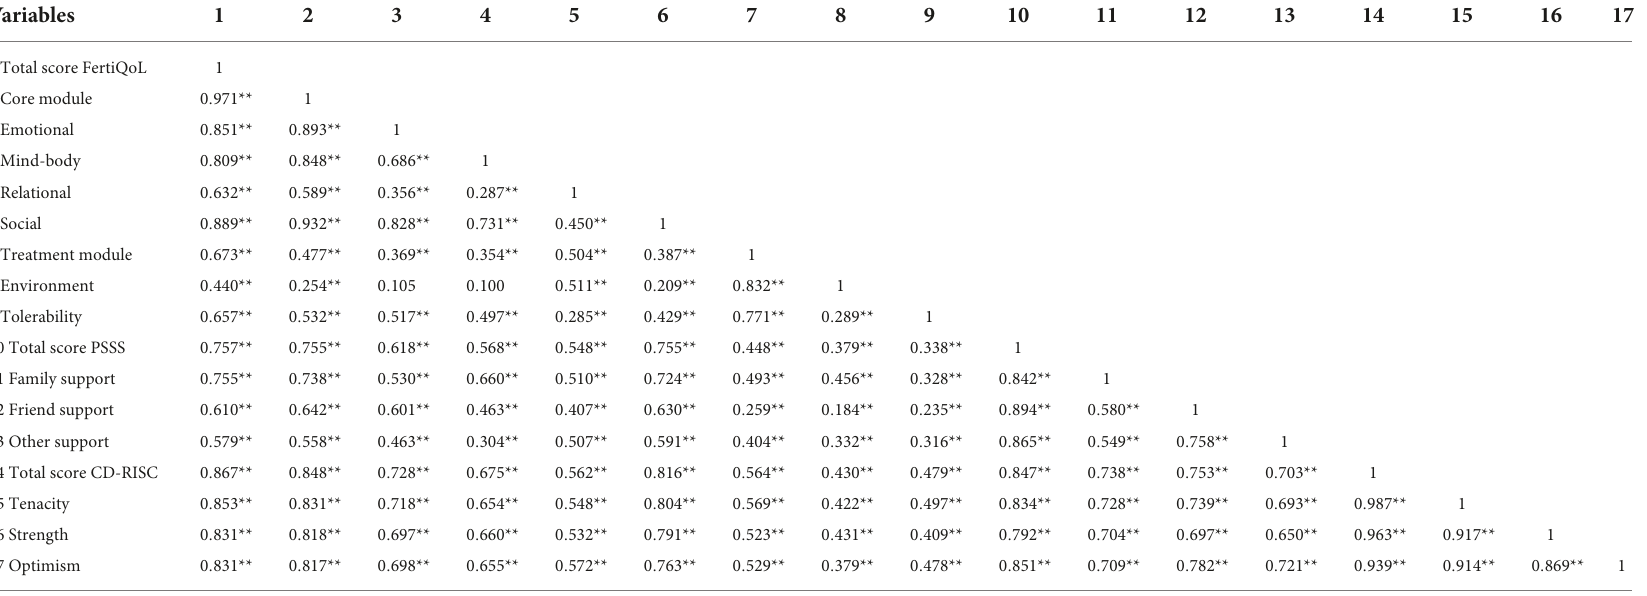
TABLE 3 Correlation analysis between fertility-related quality of life (FertiQoL), perceived social support scale (PSSS), and Connor-Davidson Resilience Scale